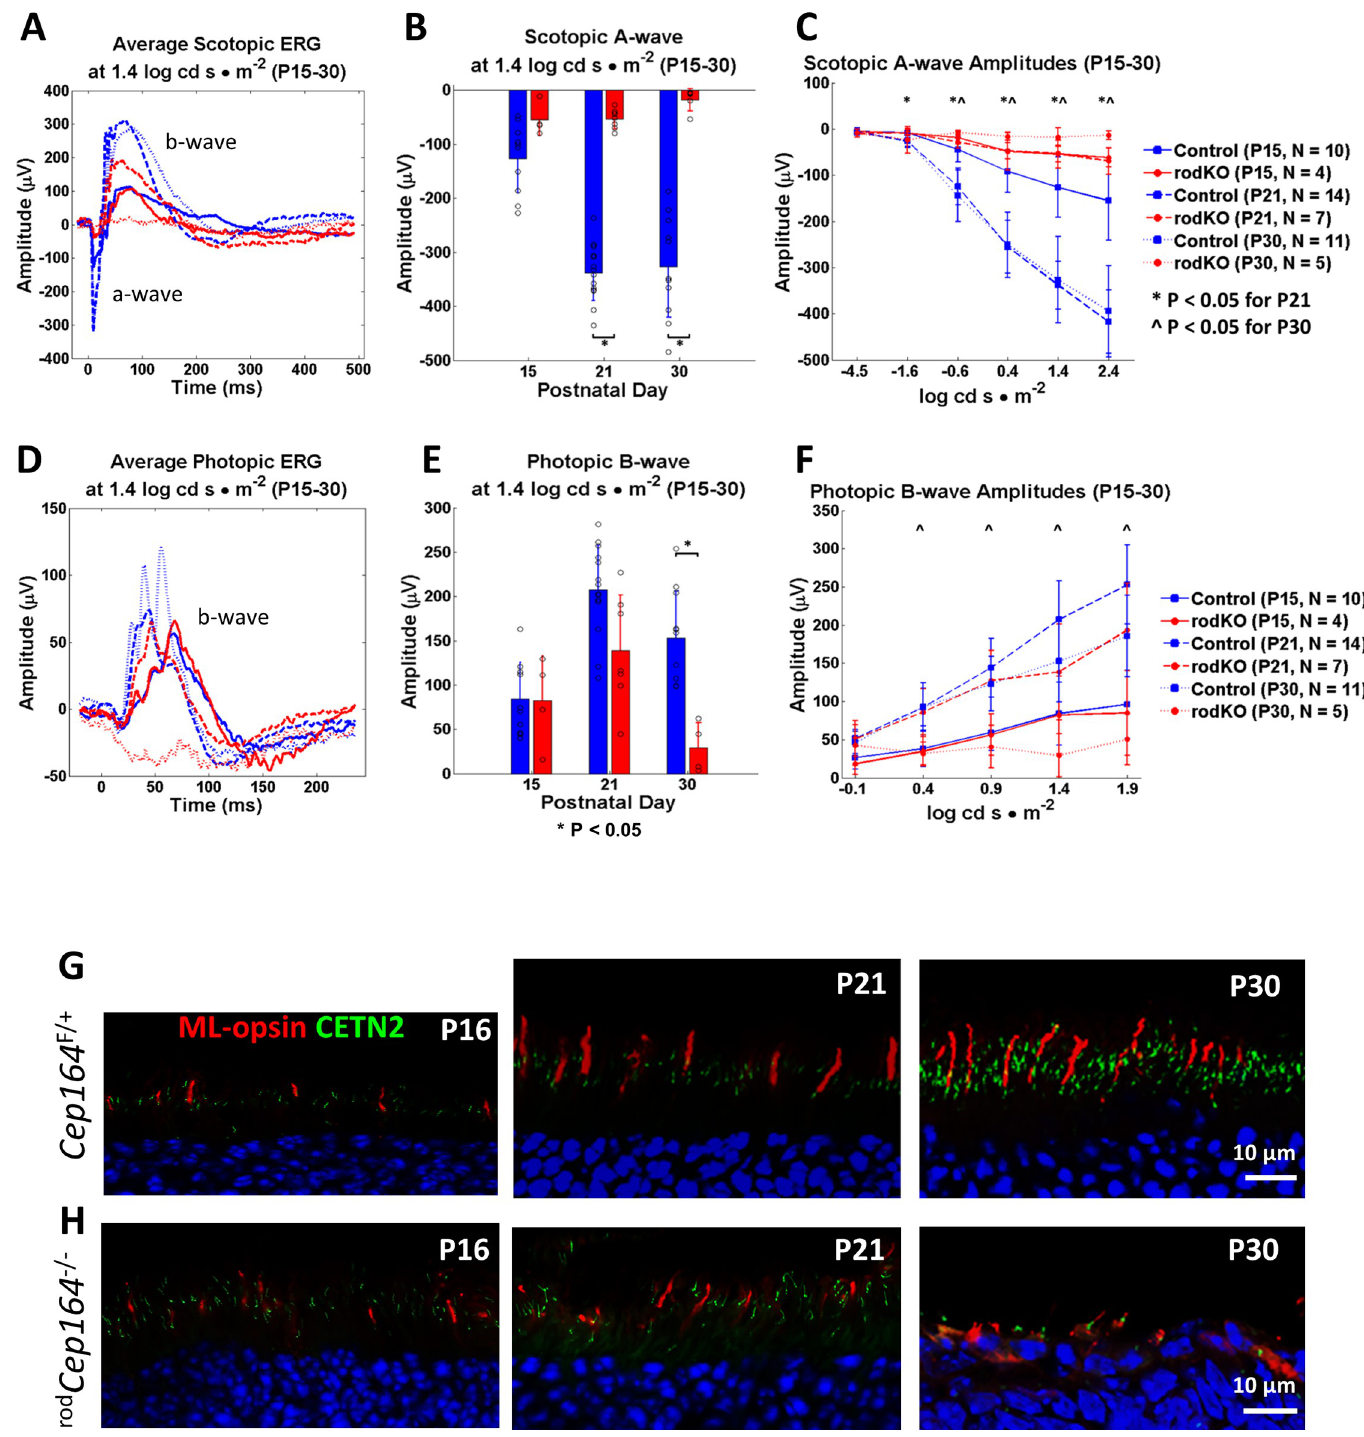
Fig 5. rod Cep164 -/- scotopic and photopic ERG and fate of cones. A, control (blue) and rod Cep164 -/- mice (red) were dark-adapted overnight and exposed under scotopic conditions to flashes of 1.4 log cd s/m 2 at P16, P21 and P30 (n = 4–14). Note knockout a- and b- wave amplitudes were diminished at all ages . B, statistical evaluation of amplitudes of control and knockout CEP164 scotopic ERG a-waves at P15, P21 and P30 as measured in A. At P21 and P30 � p < 0.05 t -test C, F, scotopic a-wave (C) and photopic b-wave amplitudes (F) at P16, P21 and P30 as a function of light intensity. Knockout scotopic a- and b-waves are diminished, but never extinguished. � p < 0.05 at P21 and ^ p < 0.05 at P30. D, control (blue) and rod Cep164 -/- mice (red) were exposed under photopic conditions to flashes of 1.4 log cd s/m 2 . Note, rod Cep164 -/- photopic b-waves were absent at P30. E, statistical evaluation of photopic b-wave amplitudes at 1.4 log cd s/m 2 as measured in B. G, H, immunohistochemistry with anti-ML-opsin of control (G) and rod Cep164 -/- central cryosections (H) at P16, P21 and P30. Cones on the rod Cep164 -/- background are stable until P21 but are degenerated at P30. https://doi.org/10.1371/journal.pgen.1010154.g005 PLOS Genetics | https://doi.org/10.1371/journal.pgen.1010154 September 8,